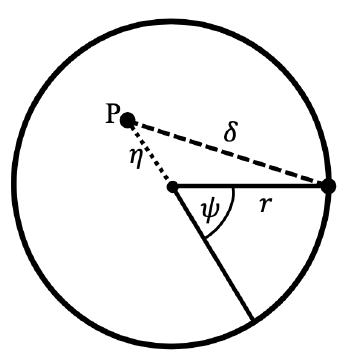
Figure 2. Geometry of a Li atom inside a spherical